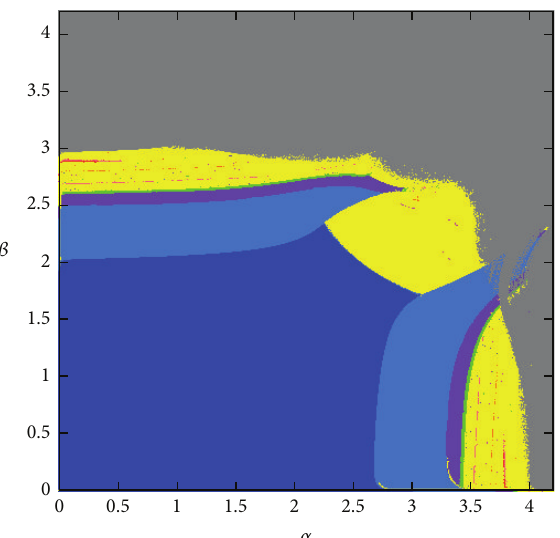
Figure 5: The strange attractor of system (10) for 𝛼 = 1.5 and 𝛽 = 2.9 .